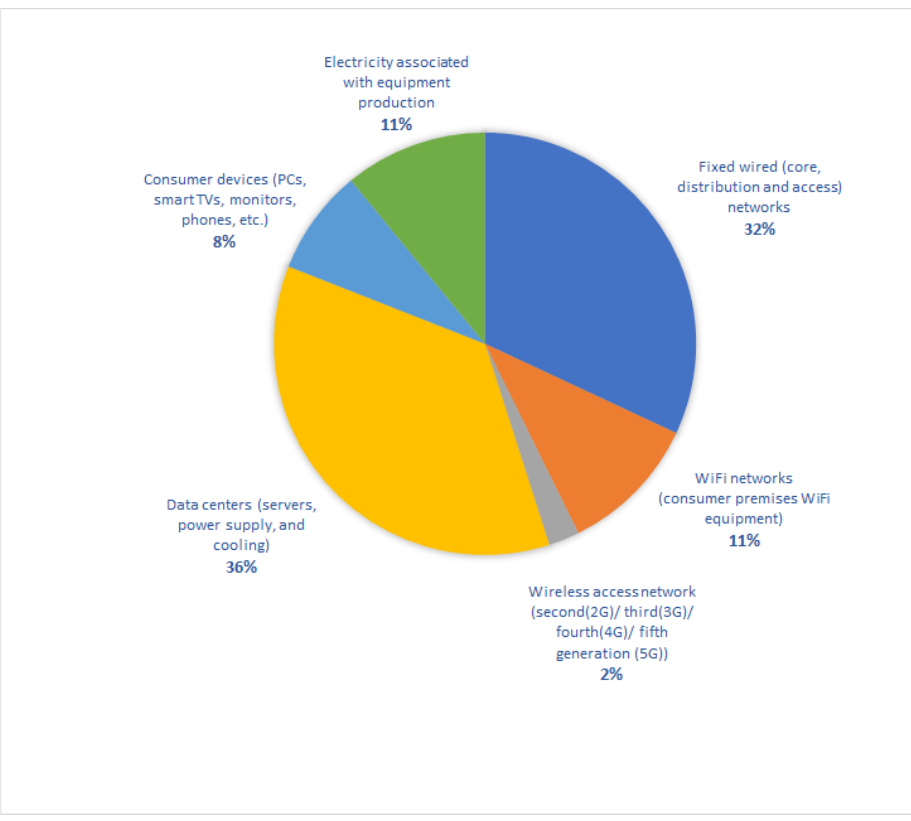
Figure 1. Projected 2030 distribution of ICT energy consumption (percent of total terawatt hours (TWh). Created from data published in: Lorincz, Capone, and Wu [36].